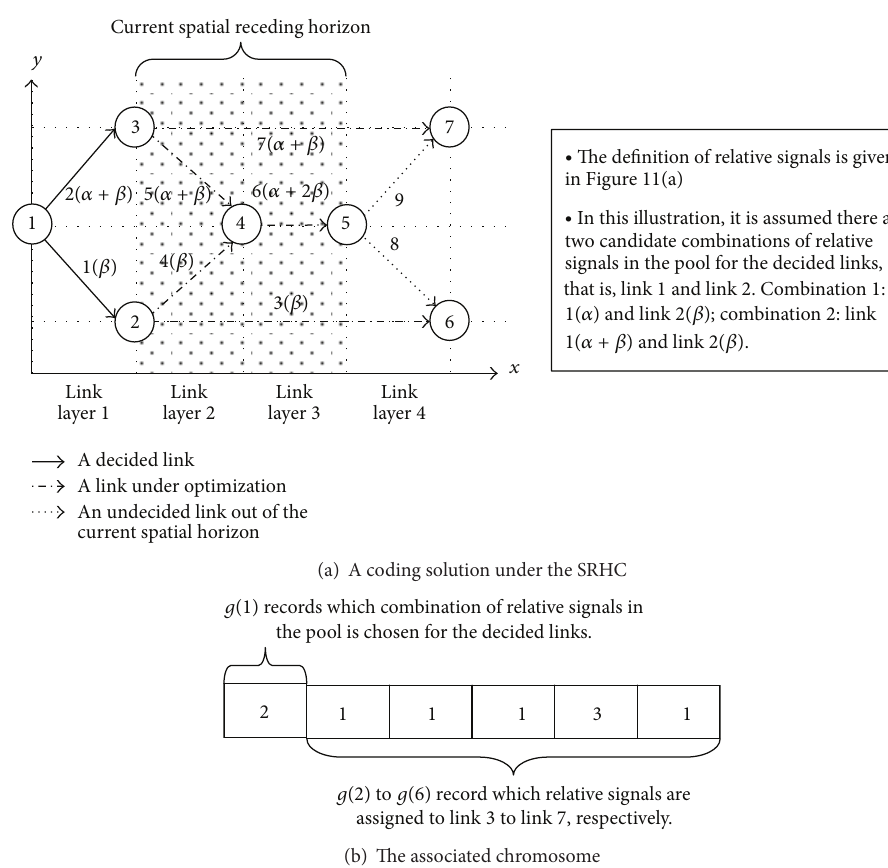
Figure 13: An illustration of the modified chromosome structure for